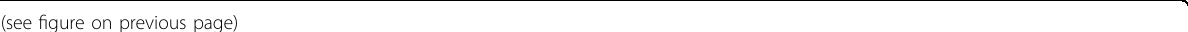
Fig. 4 Silencing of PVT1 or overexpression of FOXA1 inhibited the apoptosis and damage of podocytes in DN. a Immuno fl uorescence staining revealing the expression of synaptopodin and podocin in MPC5 cells with normal culture medium (the original magni fi cation is ×400). b Flow cytometry map demonstrating MPC5 cell apoptosis conditions with normal culture medium. c Apoptosis rate analysis for cells with normal culture medium in response to the treatment of OE-PVT1, OE-PVT1 + GSK126, sh-NC, sh-FOXA1, OE-PVT1 + sh-FOXA1; * p < 0.05 vs. the OE-NC group; # p < 0.05 vs. the sh-NC group; & p < 0.05 vs. the OE-PVT1 group and the sh-FOXA1 group. d Immuno fl uorescence staining revealing the expression of synaptopodin and podocin in MPC5 cells with HG culture medium (×400). e Flow cytometry map demonstrating MPC5 cell apoptosis conditions with HG culture medium. f Apoptosis rate analysis for cells with HG culture medium in response to the treatment of OE-PVT1, OE-PVT1 + GSK126, sh- NC, sh-FOXA1, and OE-PVT1 + sh-FOXA1. g The protein levels of apoptosis-related factors (Bcl-2, Bax, and cleaved caspase-3) in response to the treatment of OE-PVT1, OE-PVT1 + GSK126, sh-NC, sh-FOXA1, and OE-PVT1 + sh-FOXA1 with normal culture medium. h The protein levels of apoptosis-related factors (Bcl-2, Bax, and cleaved caspase-3) in response to the treatment of OE-PVT1, OE-PVT1 + GSK126, sh-NC, sh-FOXA1, and OE- PVT1 + sh-FOXA1 with HG culture medium; * p < 0.05 vs. the sh-NC group; # p < 0.05 vs. the pcDNA-NC group; & p < 0.05 vs. the sh-PVT1 group and the pcDNA-FOXA1 group. I, The protein level of FOXA1 after the silencing or overexpression of FOXA1 in podocytes; * p < 0.05 vs. the sh-NC group; # p < 0.05 vs. the pcDNA-NC group. The measurement data are expressed as the mean ± standard deviation, and the comparisons among multiple groups were analyzed by one-way analysis of variance (ANOVA). The experiment was repeated three times. PTV1, plasmacytoma variant translocation 1; DN, diabetic nephropathy; MPC5, mouse podocyte clone 5; HG, high glucose; NC, negative control; OE, overexpressed; GSK126, EZH2 inhibitor; FOXA1, forkhead box A1; Bcl-2, B cell lymphoma 2; Bax, Bcl-2-associated X protein; GAPDH, glyceraldehyde-3-phosphate